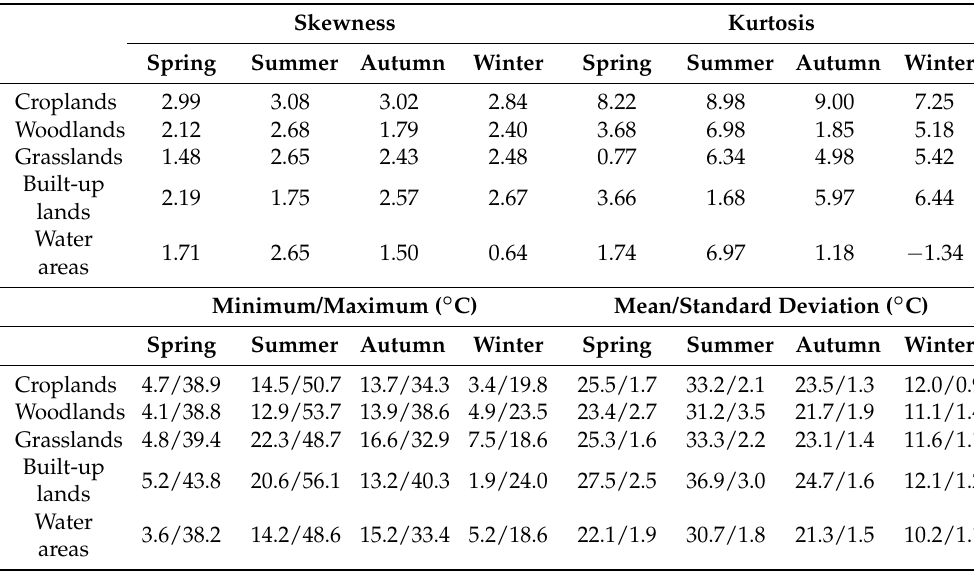
Table 4. Descriptive statistics, skewness, and kurtosis assessment of the probability distributions shown in Figure 7. Skewness